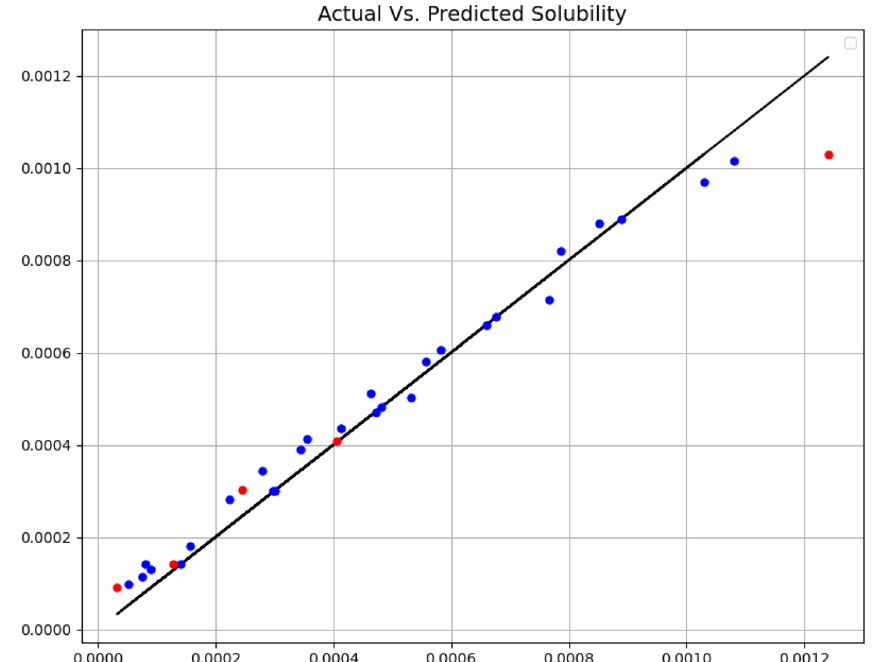
Figure 1. Expected and estimated values (ADA + DT).